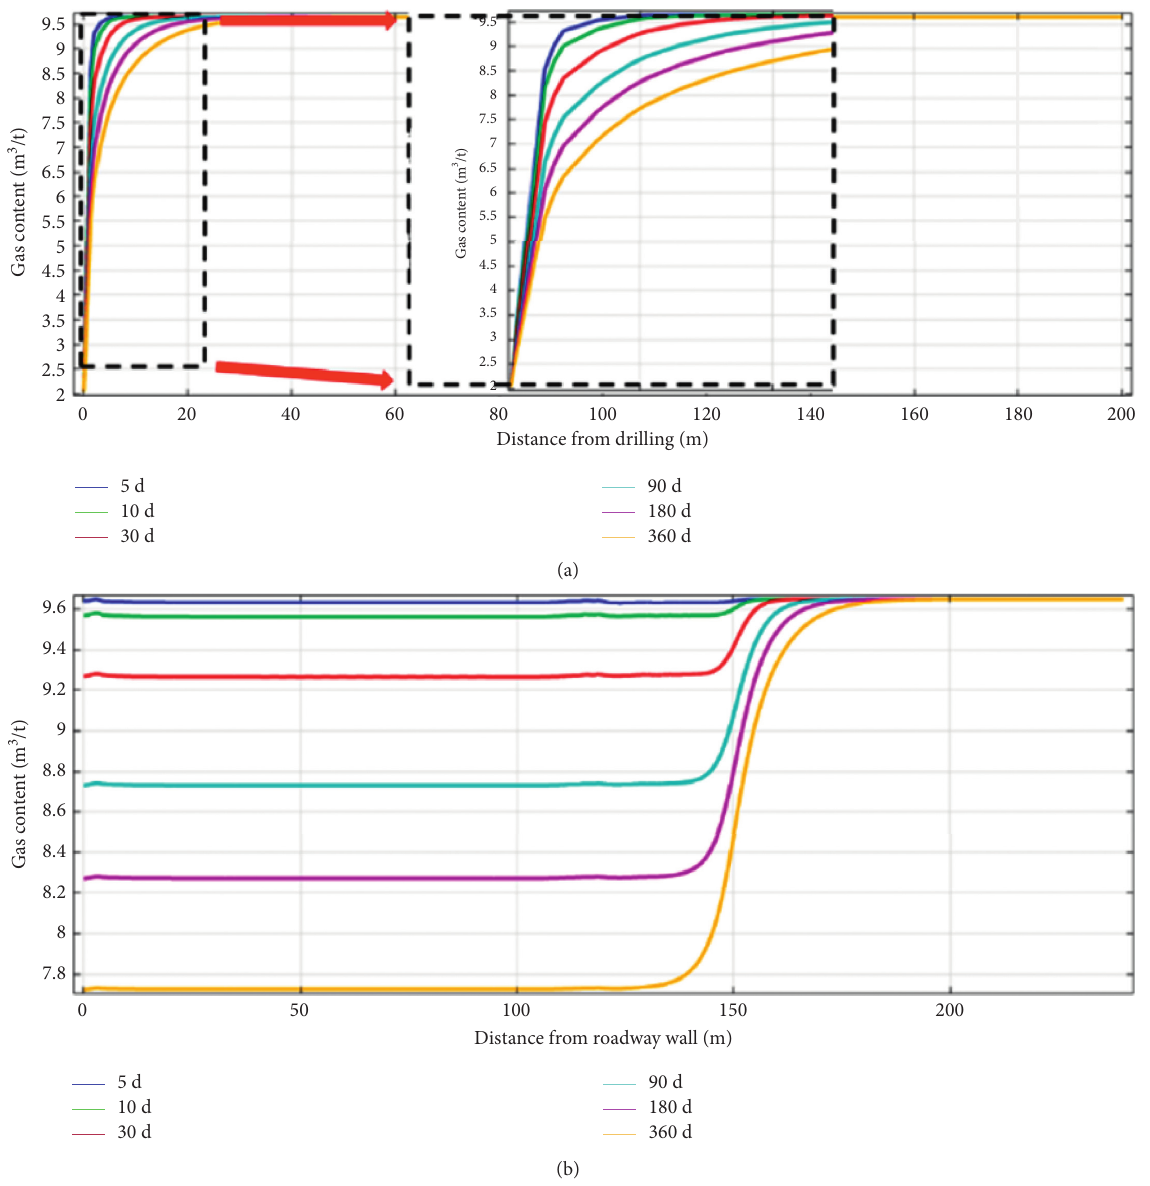
Figure 14: Distribution of gas content in 150m borehole with different drainage time: (a) gas content distribution on the monitoring line in the strike direction; (b) distribution of gas content in the trend direction monitoring